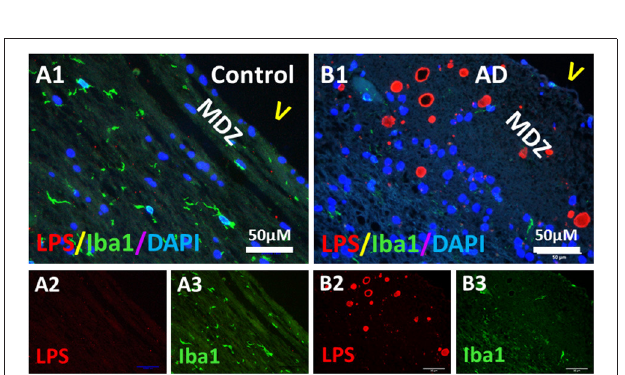
FIGURE 6 | Colocalization of LPS with CRP. (A) LPS (A1) and CRP (A2) in control PVWM were co-localized (A3) . (B) LPS (B1) and CRP (B2) in AD PVWM were co-localized (B3) . Note: LPS, lipopolysaccharide; CRP, C-reactive protein; V, ventricle; PVWM, periventricular white matter; AD, Alzheimer’s disease; Bar = 50 µ m.